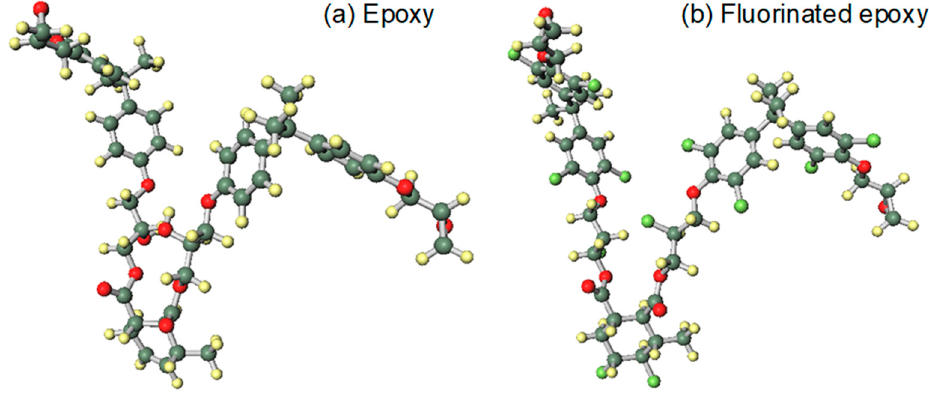
Figure 5. QCC models of epoxy resin before and after fluorination. ( a ) Model of epoxy resin; ( b ) Model of fluorinated epoxy resin.